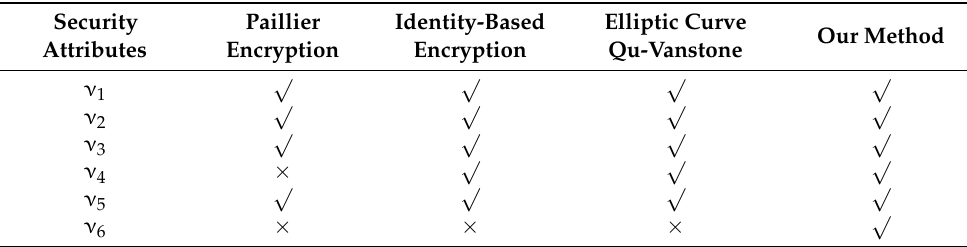
Table 1. Comparative analysis of identity authentication security between wind turbine status sensors and regional